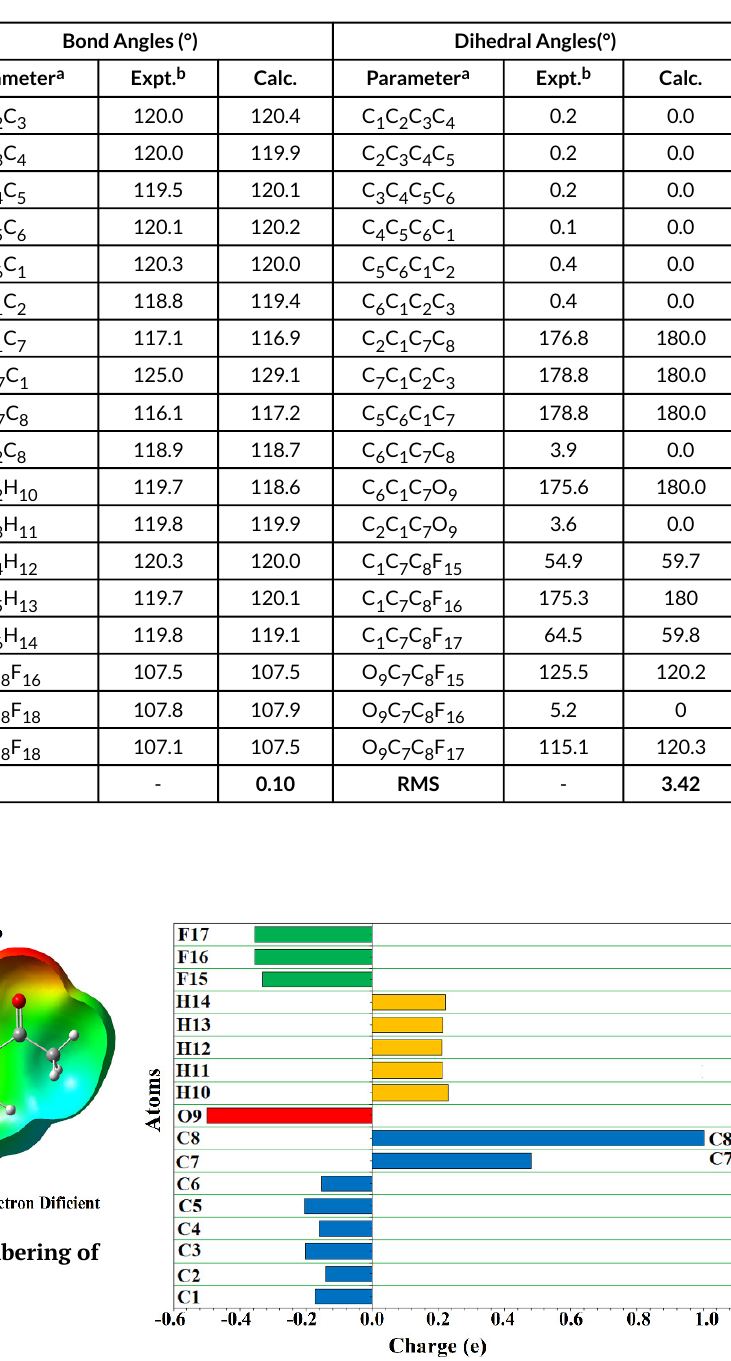
Figure 4. Optimized structure and atom numbering of